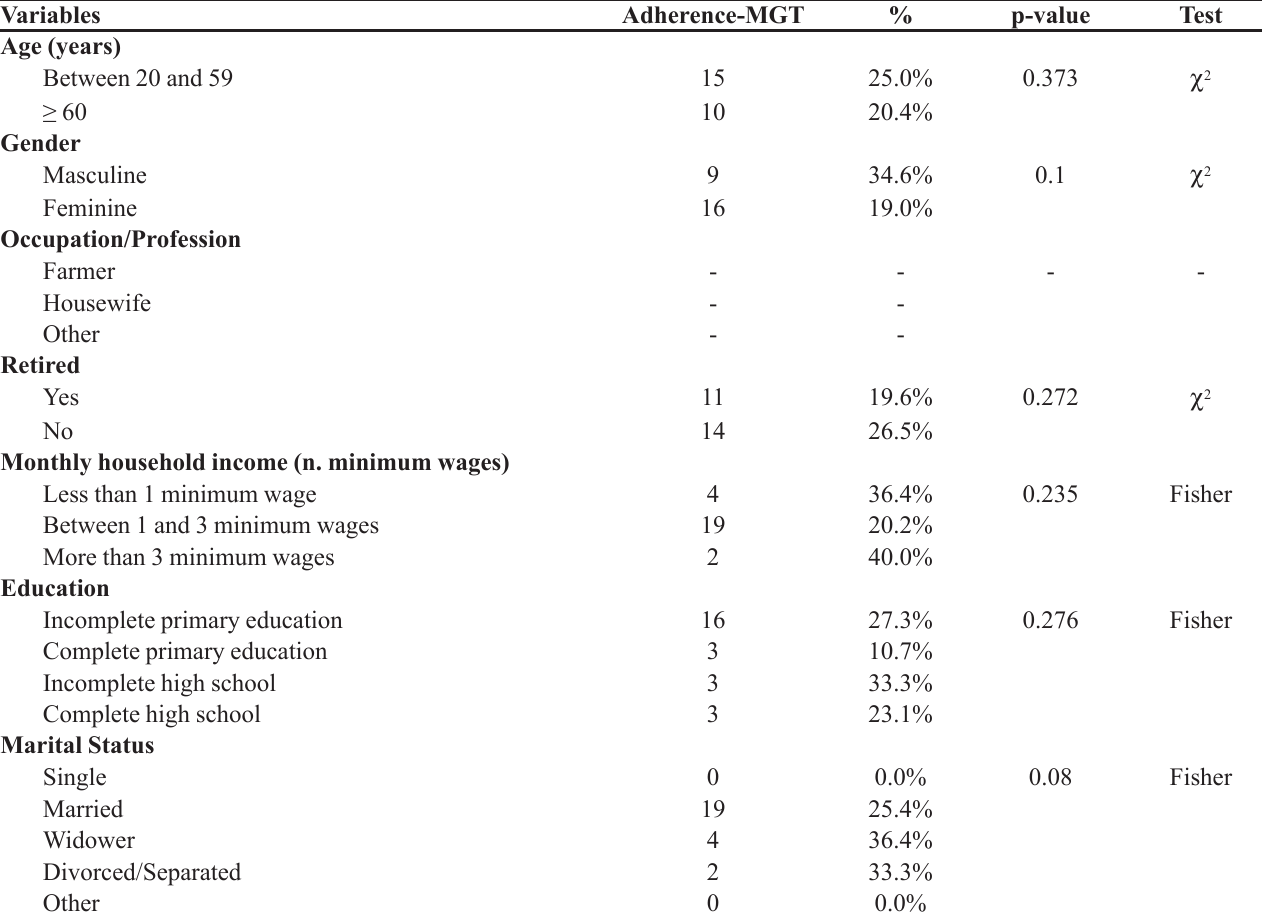
TABLE II - Distribution of sociodemographic and economic variables of Hiperdia users to analyze the association between the variables and adherence to